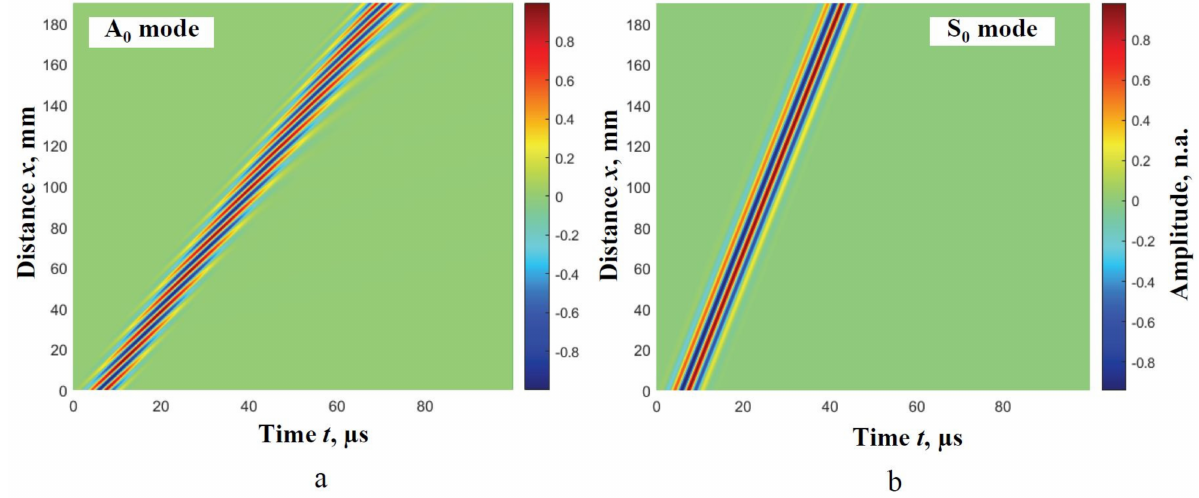
Figure 2. B-scan images of the simulated wave A 0 ( a ) and S 0 ( b ) modes of Lamb waves at 300 kHz